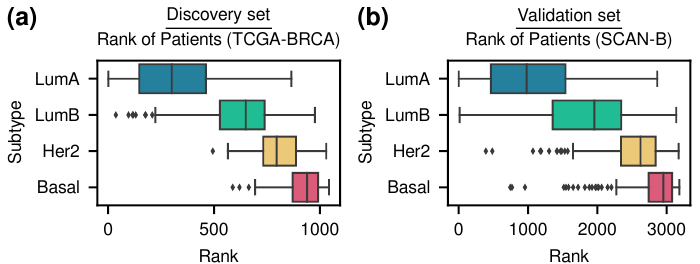
Figure 2. ( a ) TCGA-BRCA (discovery set). ( b ) SCAN-B (validation set). Ranking of patients deter- mined by risk score. The lower the risk score, the higher the rank. Risk scores were computed from the 690 genes obtained from the genetic algorithm. The left edge of the box represents the first quartile ( Q 1), and the right edge represents the third quartile ( Q 3). The vertical line inside the box represents the median. Interquartile range (IQR) is defined as ( Q 3 − Q 1), and outliers are the samples outside 1.5 times the IQR above Q 1 and below Q 3. The whisker on the left goes from Q 1 to the